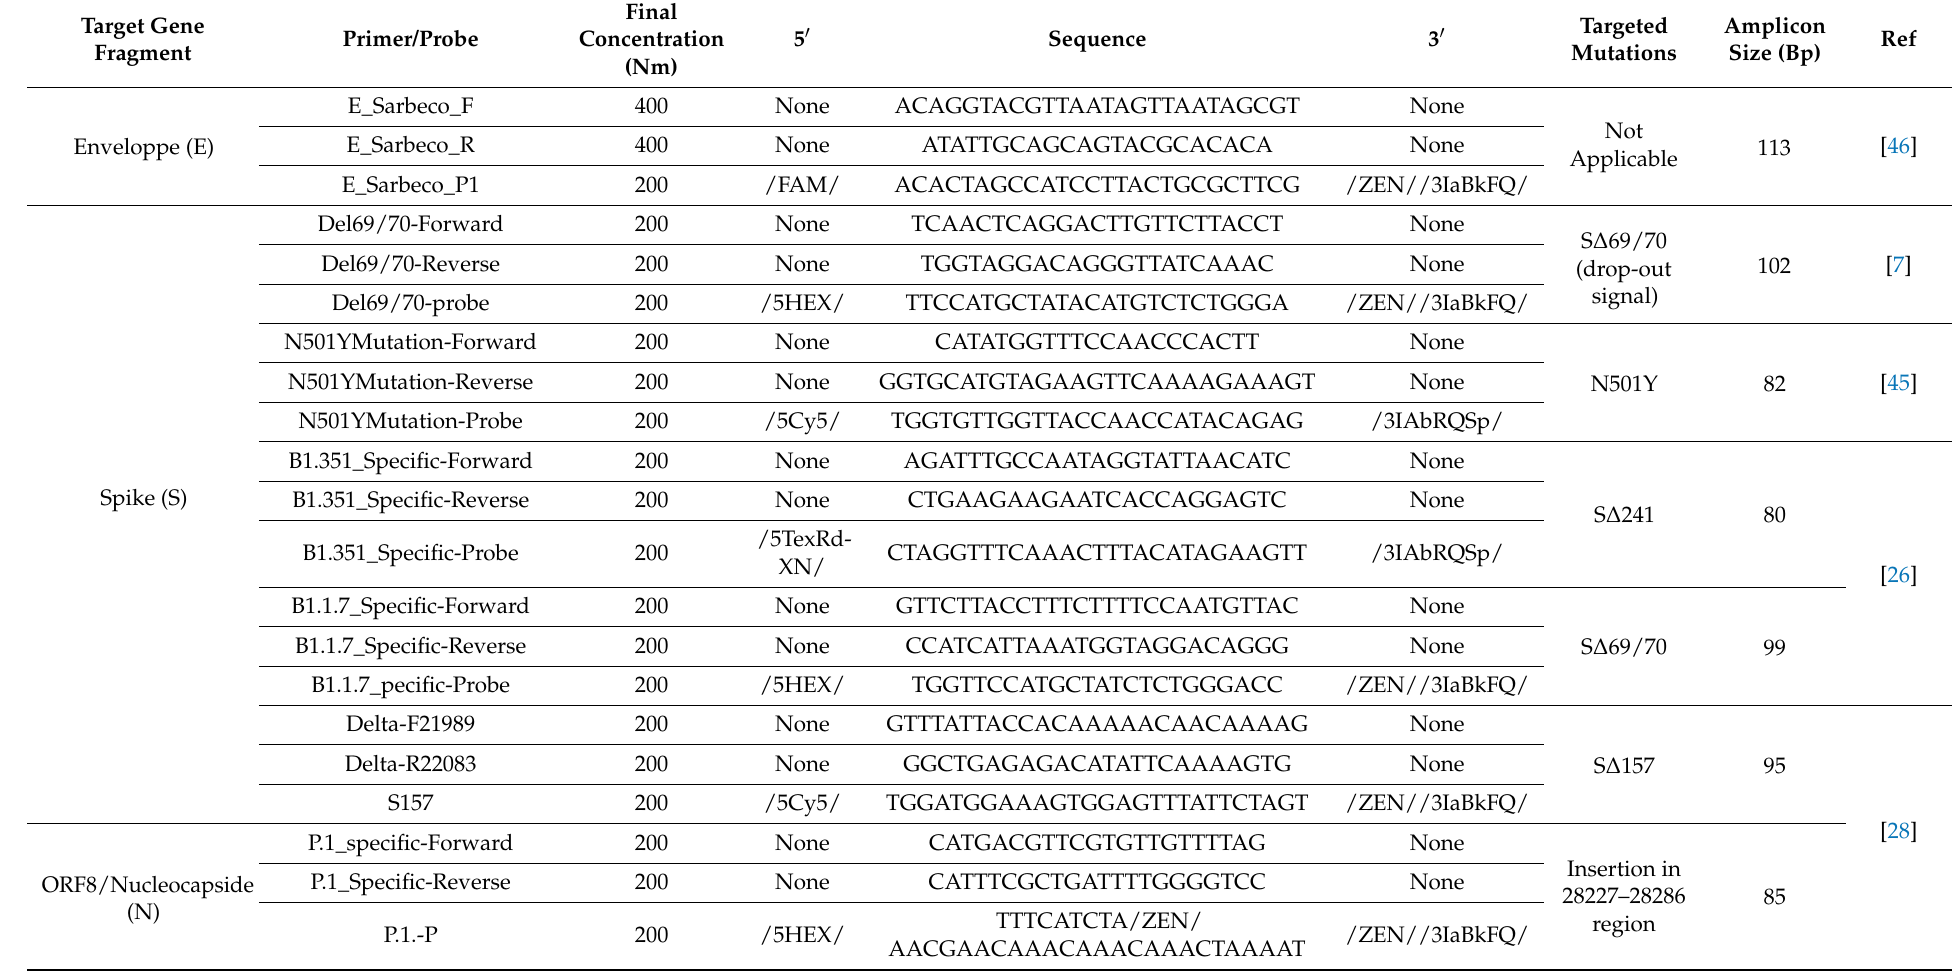
Table 2. List of dPCR